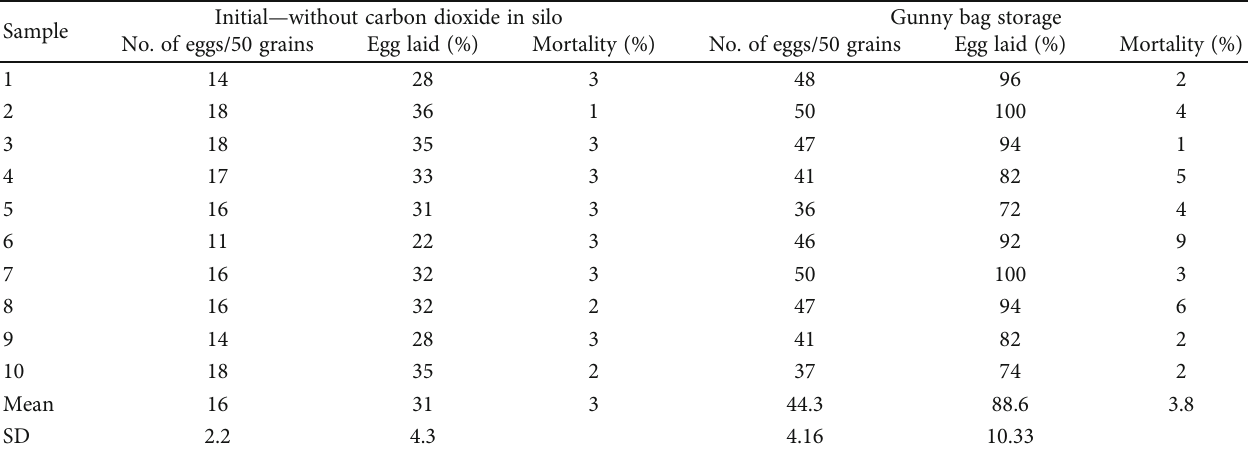
Figure 7: Mortality of Callosobruchus maculatus egg, larva, pupa, and adult at (a) 70% CO Table 2: Percentage of eggs laid and adult emergence in bulk grain silo without CO